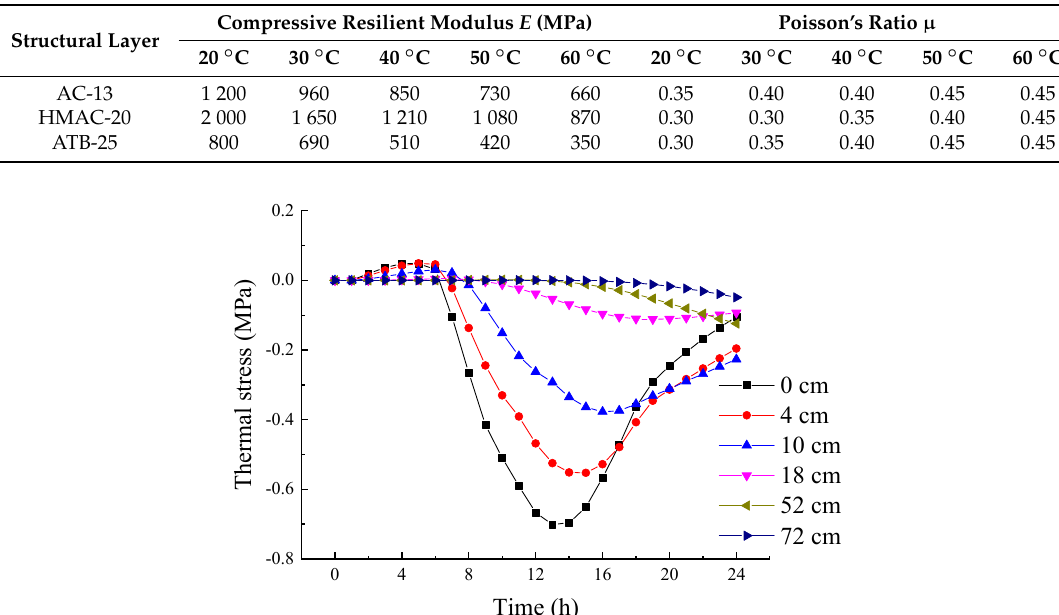
Table 10. Material elastic parameters at different temperatures.